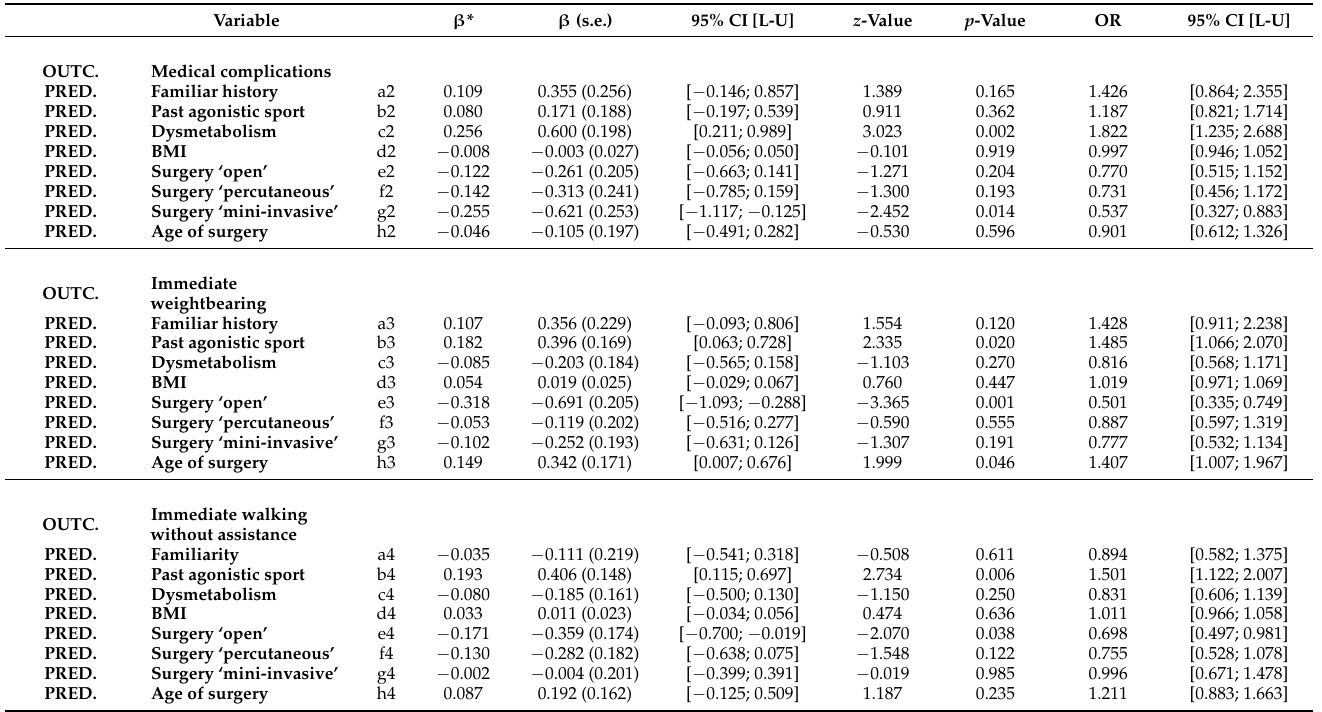
Table 5. Covariances (standardized) between dichotomous outcomes of the